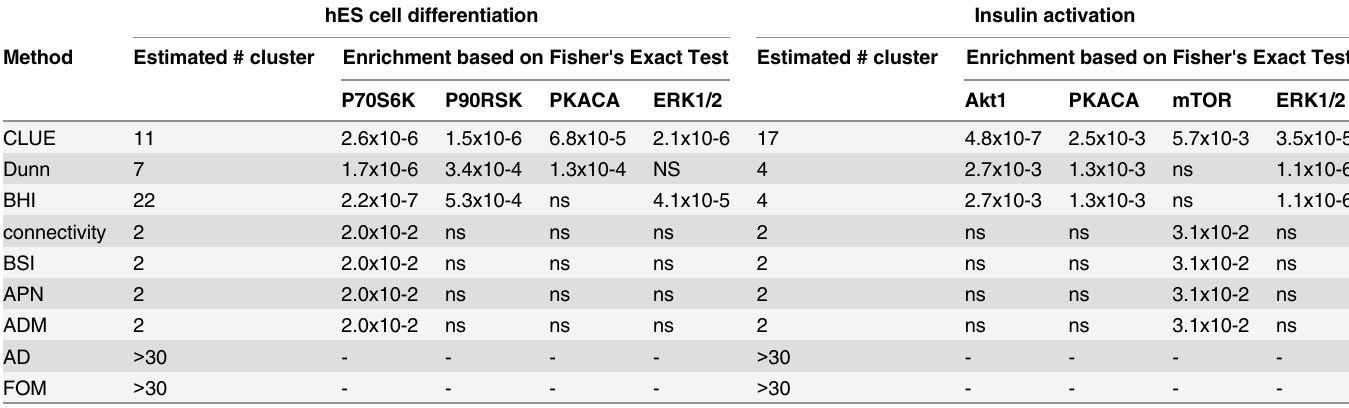
Table 1. Comparison of CLUE with alternative approaches on the two phosphoproteomics